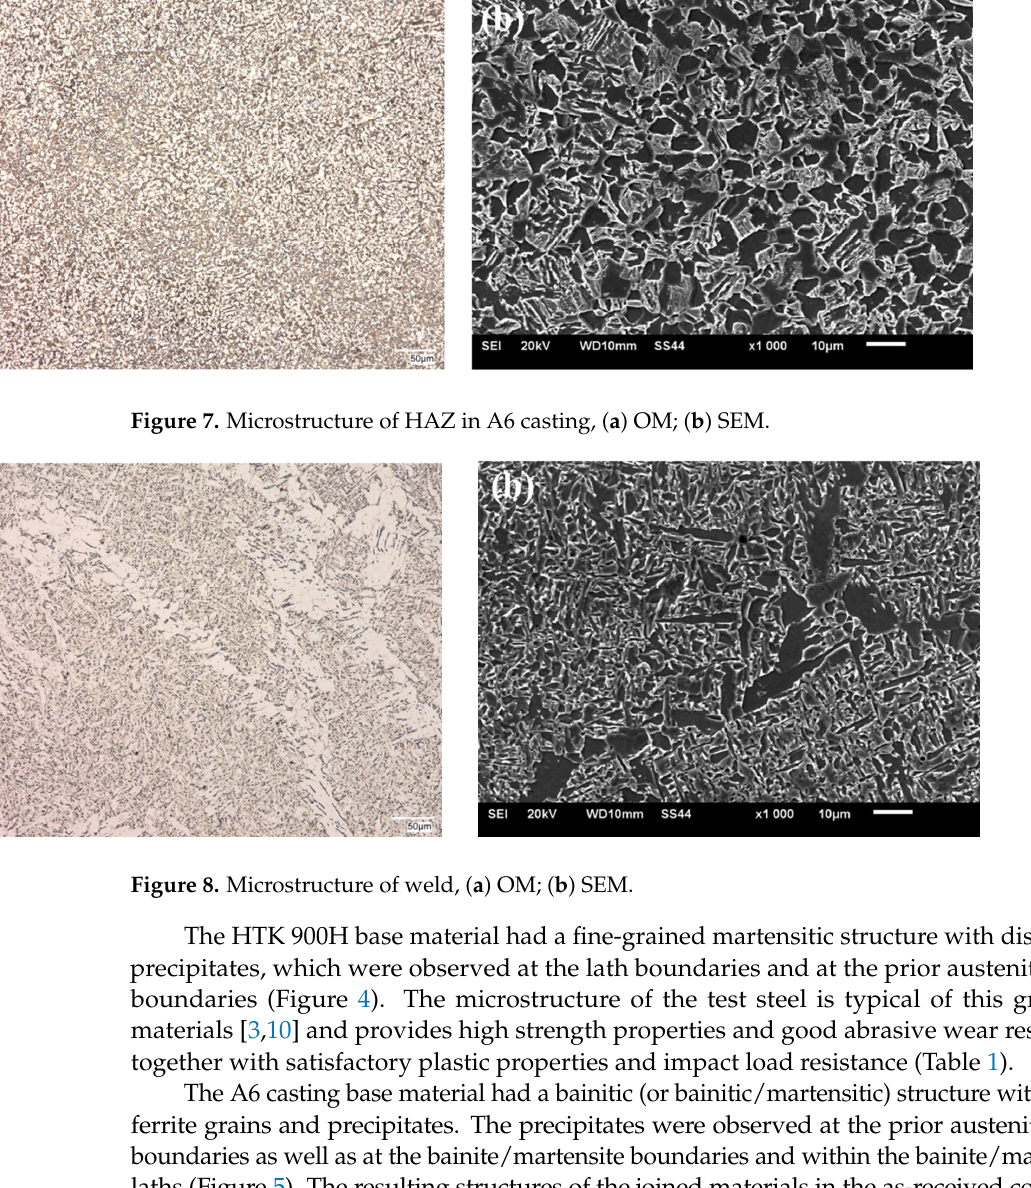
Figure 6. Microstructure of HAZ in HTK 900H steel, ( a ) OM; ( b ) SEM.